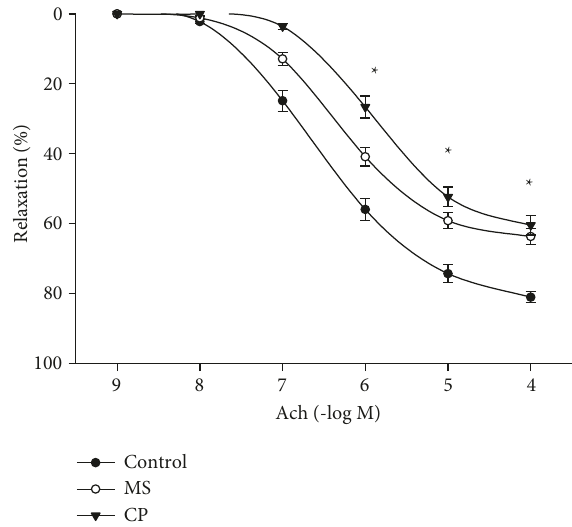
Figure 7: Aortic in vitro relaxation produced by acetylcholine in NE-precontracted aortic rings (1 μ M) from control, metabolic syndrome (MS), and critical period (CP) rats. MS rats ingested sucrose solution during six months; CP animals ingested sucrose solution during postnatal days 12 to 28. Control rats received tap water. Values are means ± SEM; ∗ P < 0 . 01 versus the control